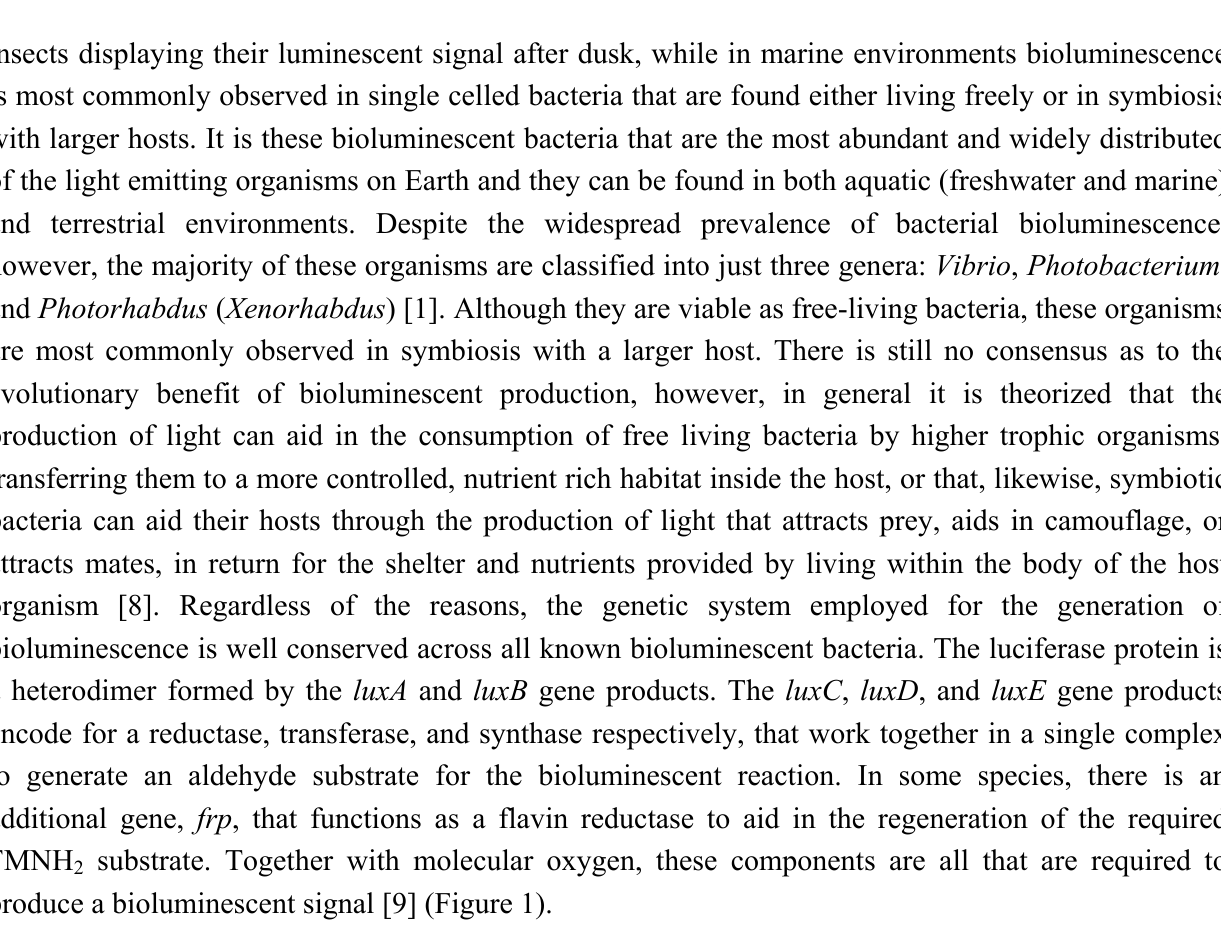
Figure 1. The luxCDABEfrp genes work synergistically with endogenous myristic acid, to generate a bioluminescent signal. The frp gene is not found in all FMN, and O 2 organisms expressing the remaining lux genes. Originally published in and used with permission from